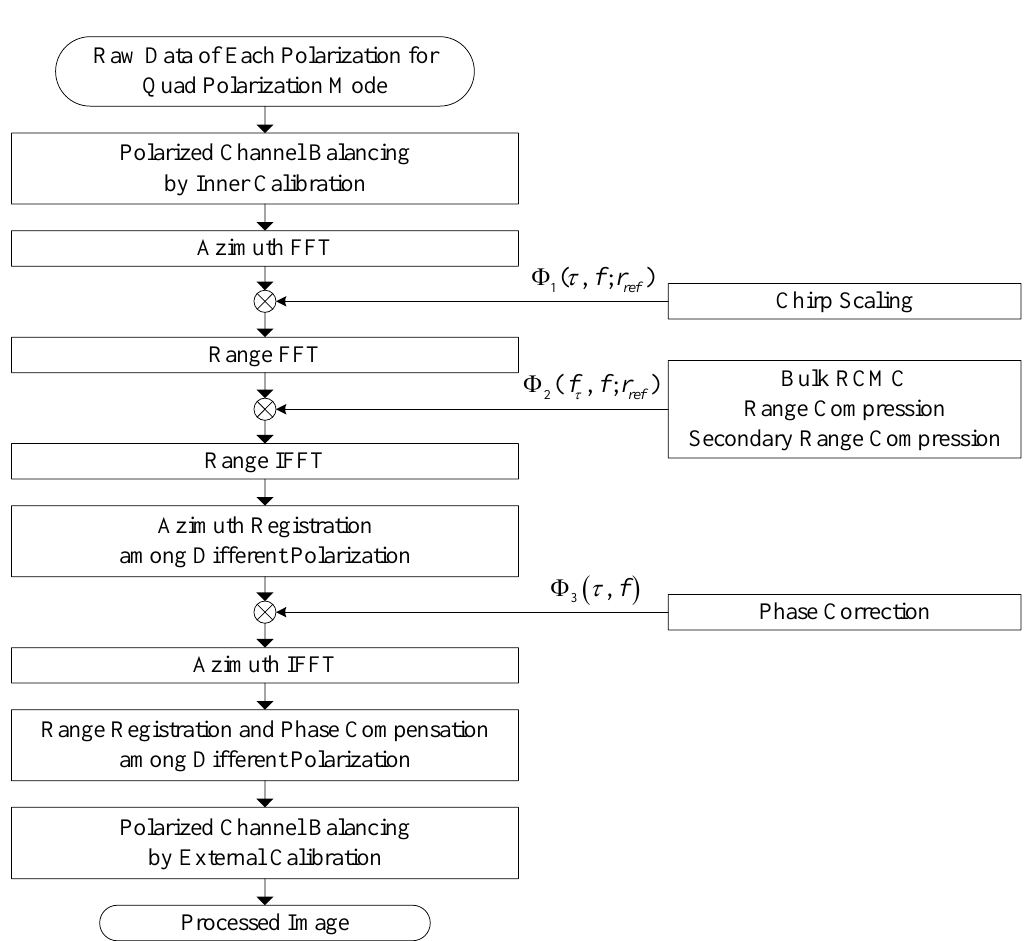
Figure 4. Block diagram of chirp scaling (CS) algorithm for GF-3 quad polarization SAR processing with polarized calibration.